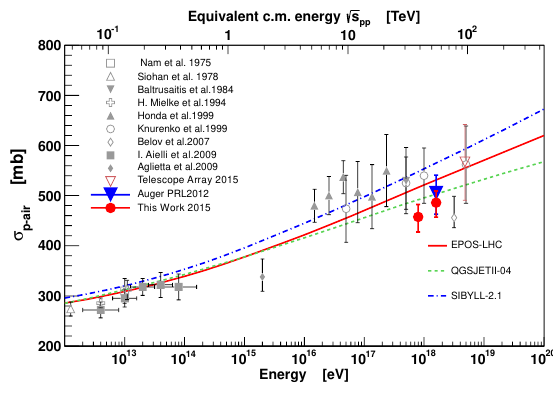
Figure 3. The σ p − air measurement compared to previous data and model predictions.